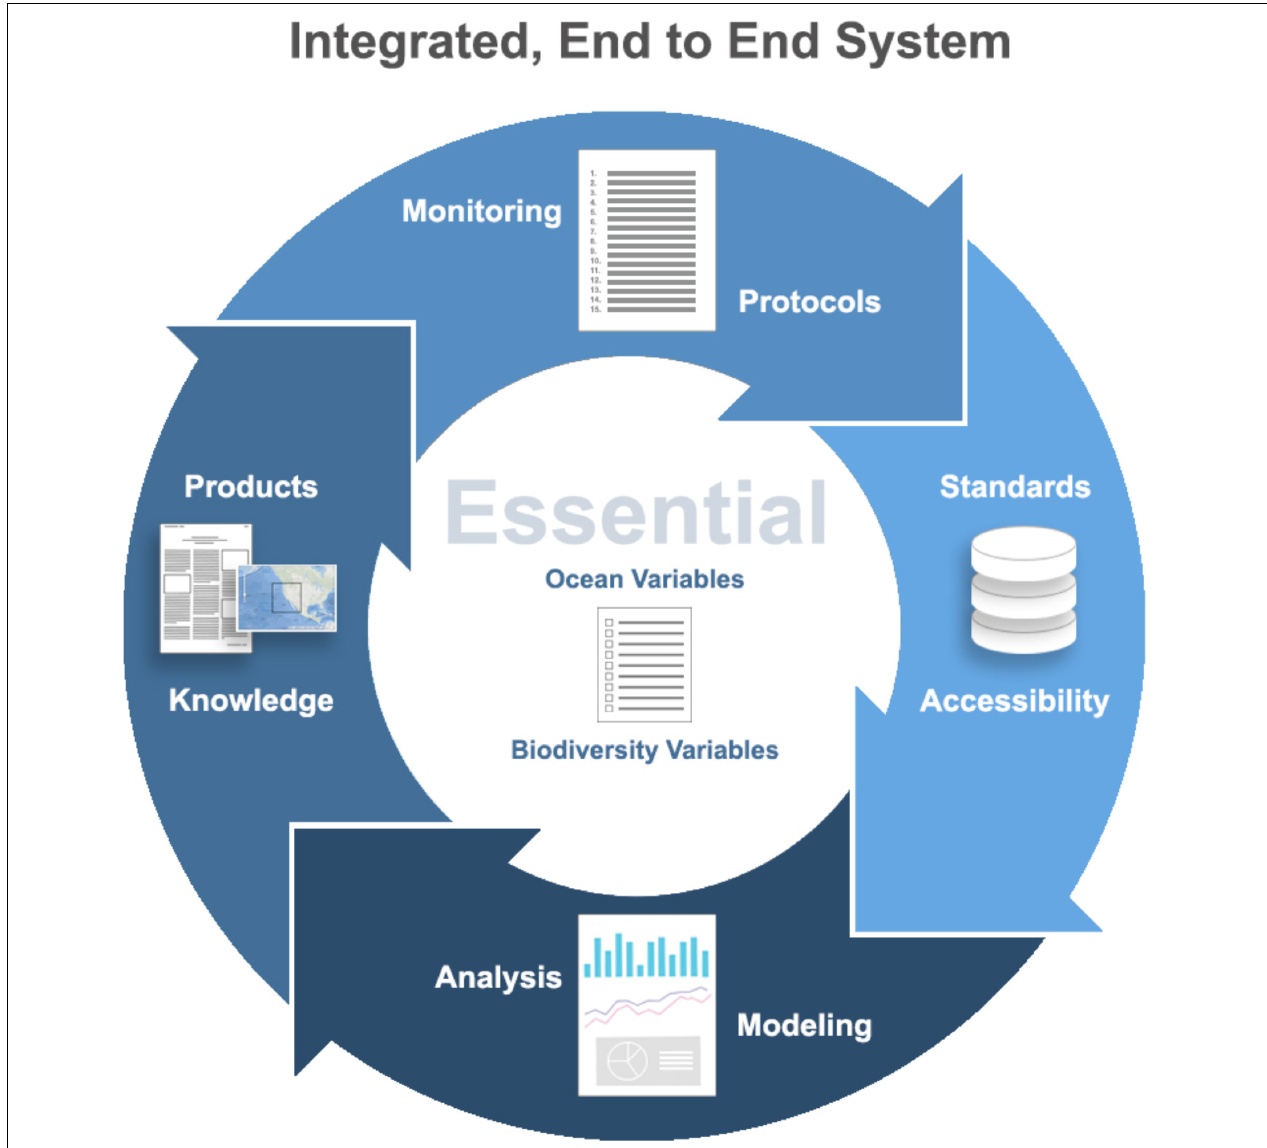
FIGURE 2 | An integrated system would allow for different pieces of the system to influence and guide one another.